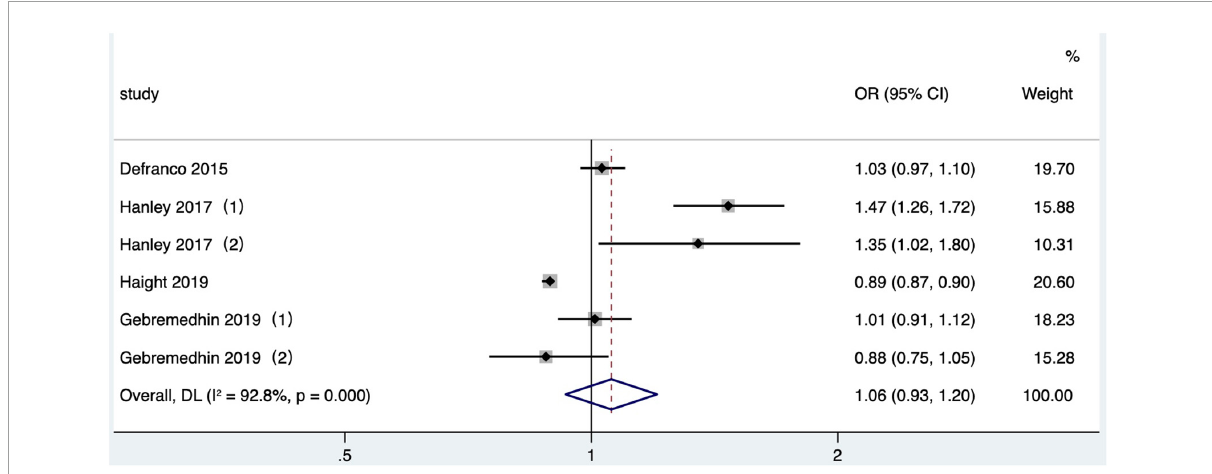
FIGURE11 Meta-analysis forest map of the effect of short IPI on gestational diabetes. Hanley et al. (36) (1) was non-matching data, and Hanley et al. (36) (2) was within-mother matching data; Gebremedhin et al. (39) (1) was non-matching data, and Gebremedhin et al. (39) (2) was within-mother matching data.